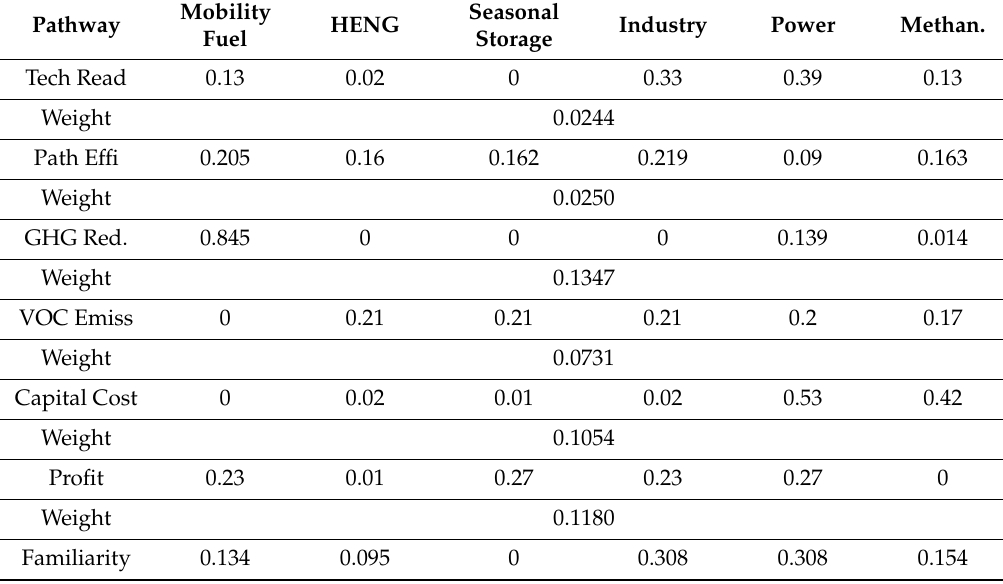
Table 18. Application of simple additive weighting (SAW) Method to Selection of power-to-gas Pathways (Source: own